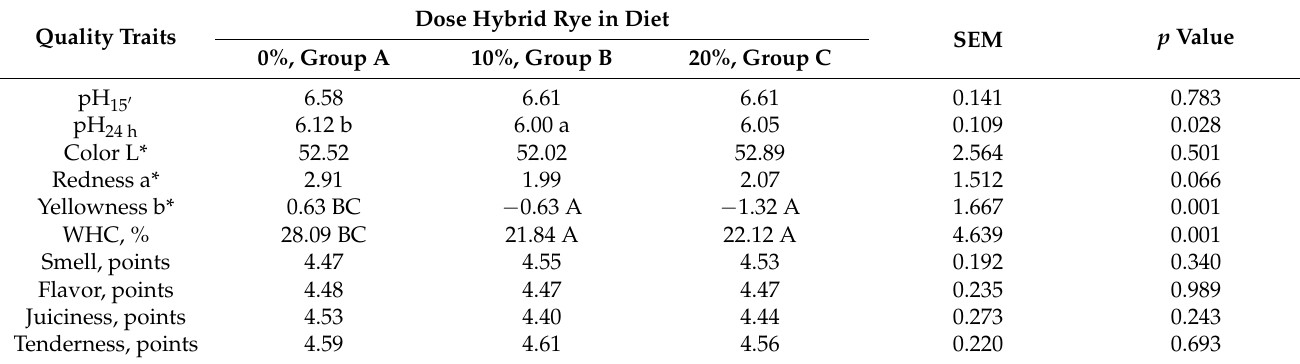
Table 7. Selected quality traits of breast muscles of chicken broilers fed with different amounts of cereals in diet. Quality